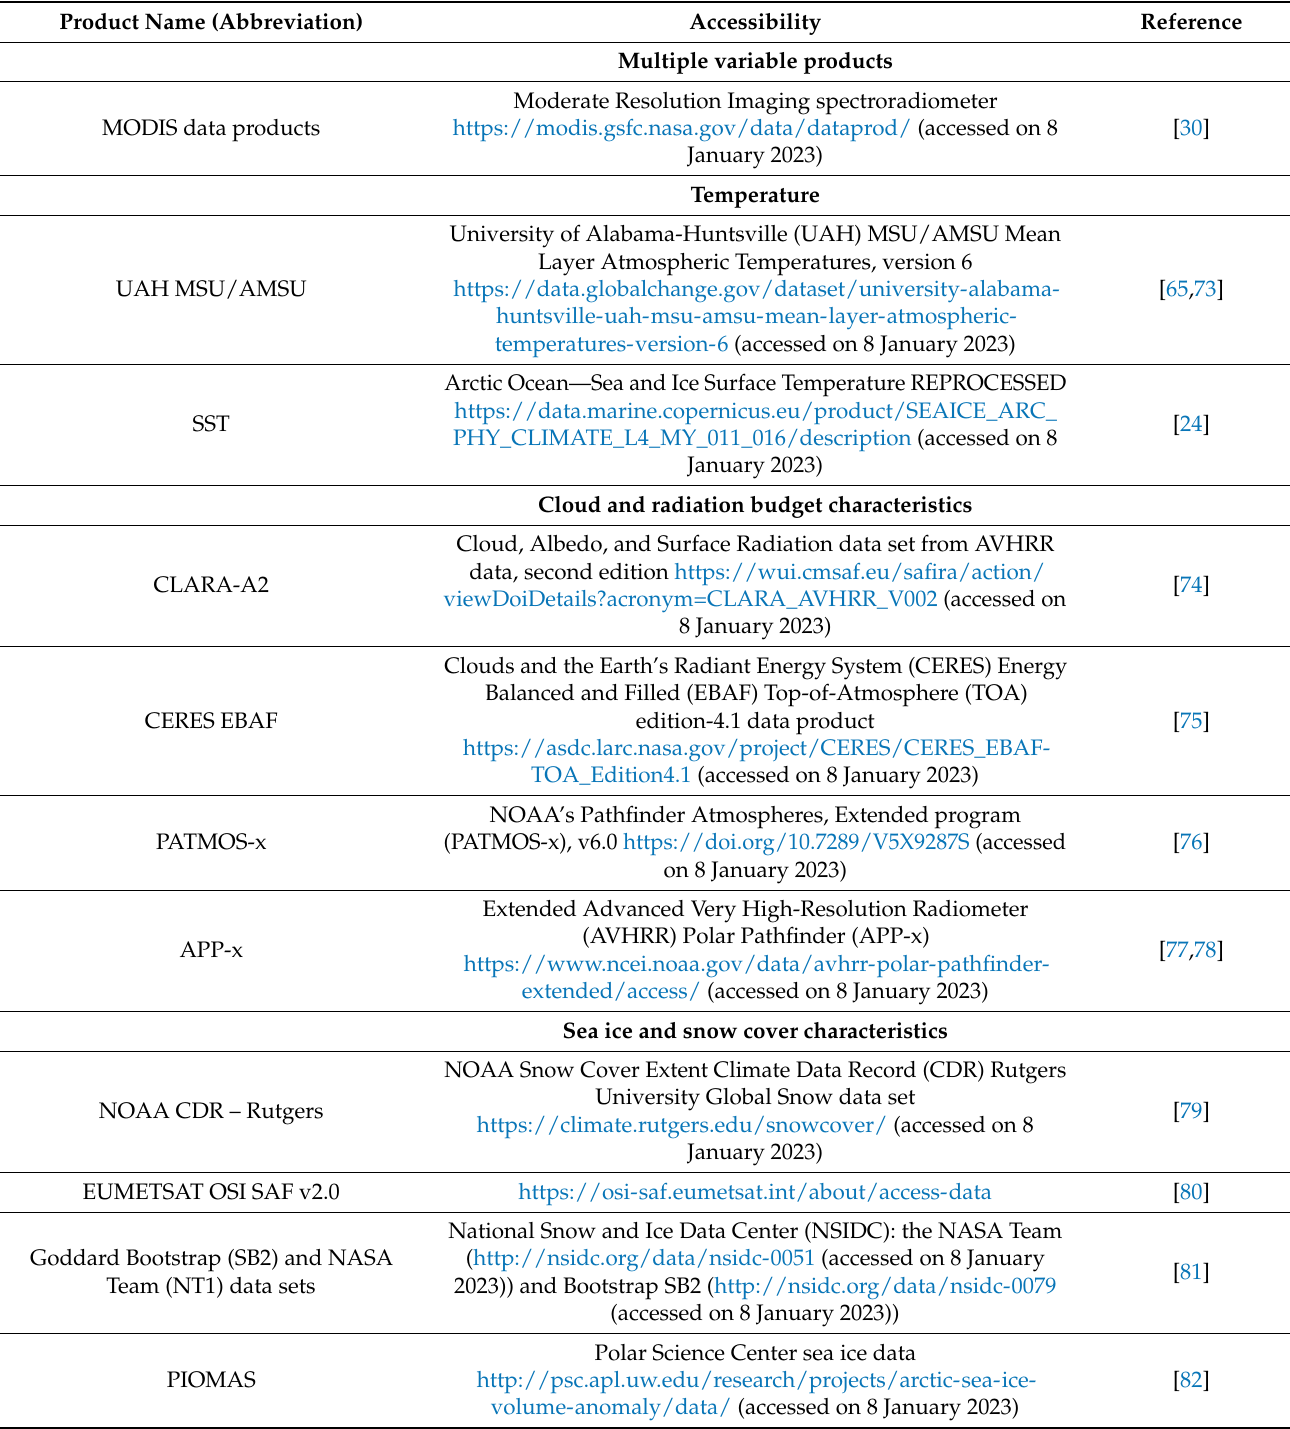
Table 2. Actively used climatic-quality remote-sensing products complementing the essential climate variables from ESA